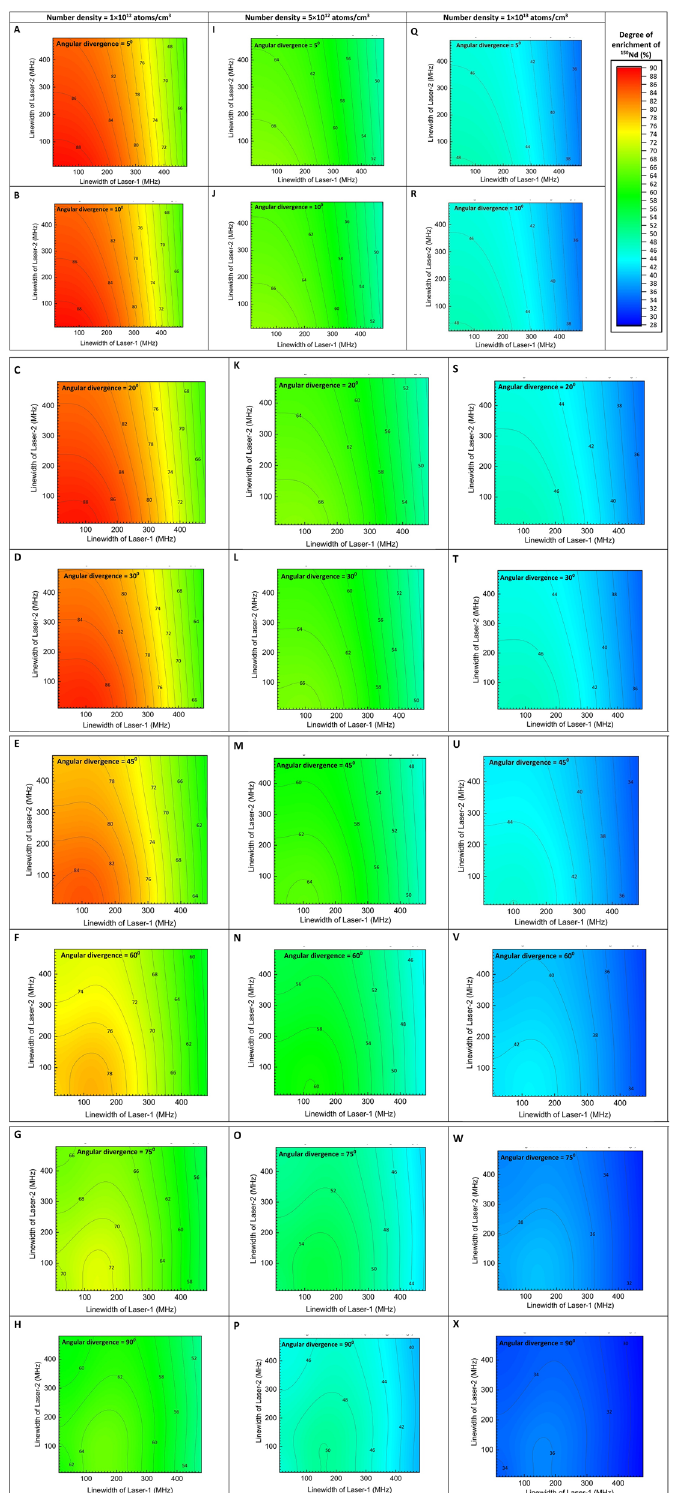
Figure 5. A plot of the dependence of the degree of enrichment on the bandwidth of excitation lasers calculated for different number densities. Peak power densities of the first, second and third lasers have been set to 20, 20 and 78,000 W/cm 2